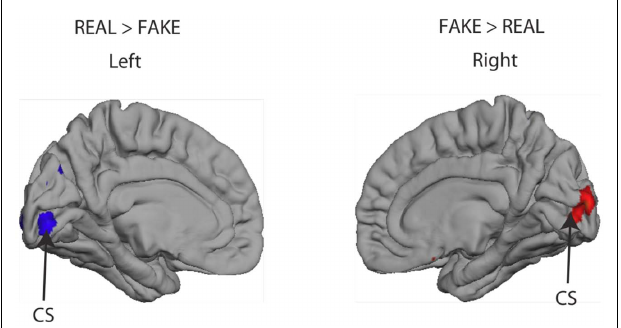
FIGUREA1 |Activation ( Z > 2.3, uncorrected) in the calcarine sulcus (CS) dependent on whether or not the person was viewing an image of a genuine Rembrandt (REAL vs. FAKE). No other significant activations were observed elsewhere in the brain to this